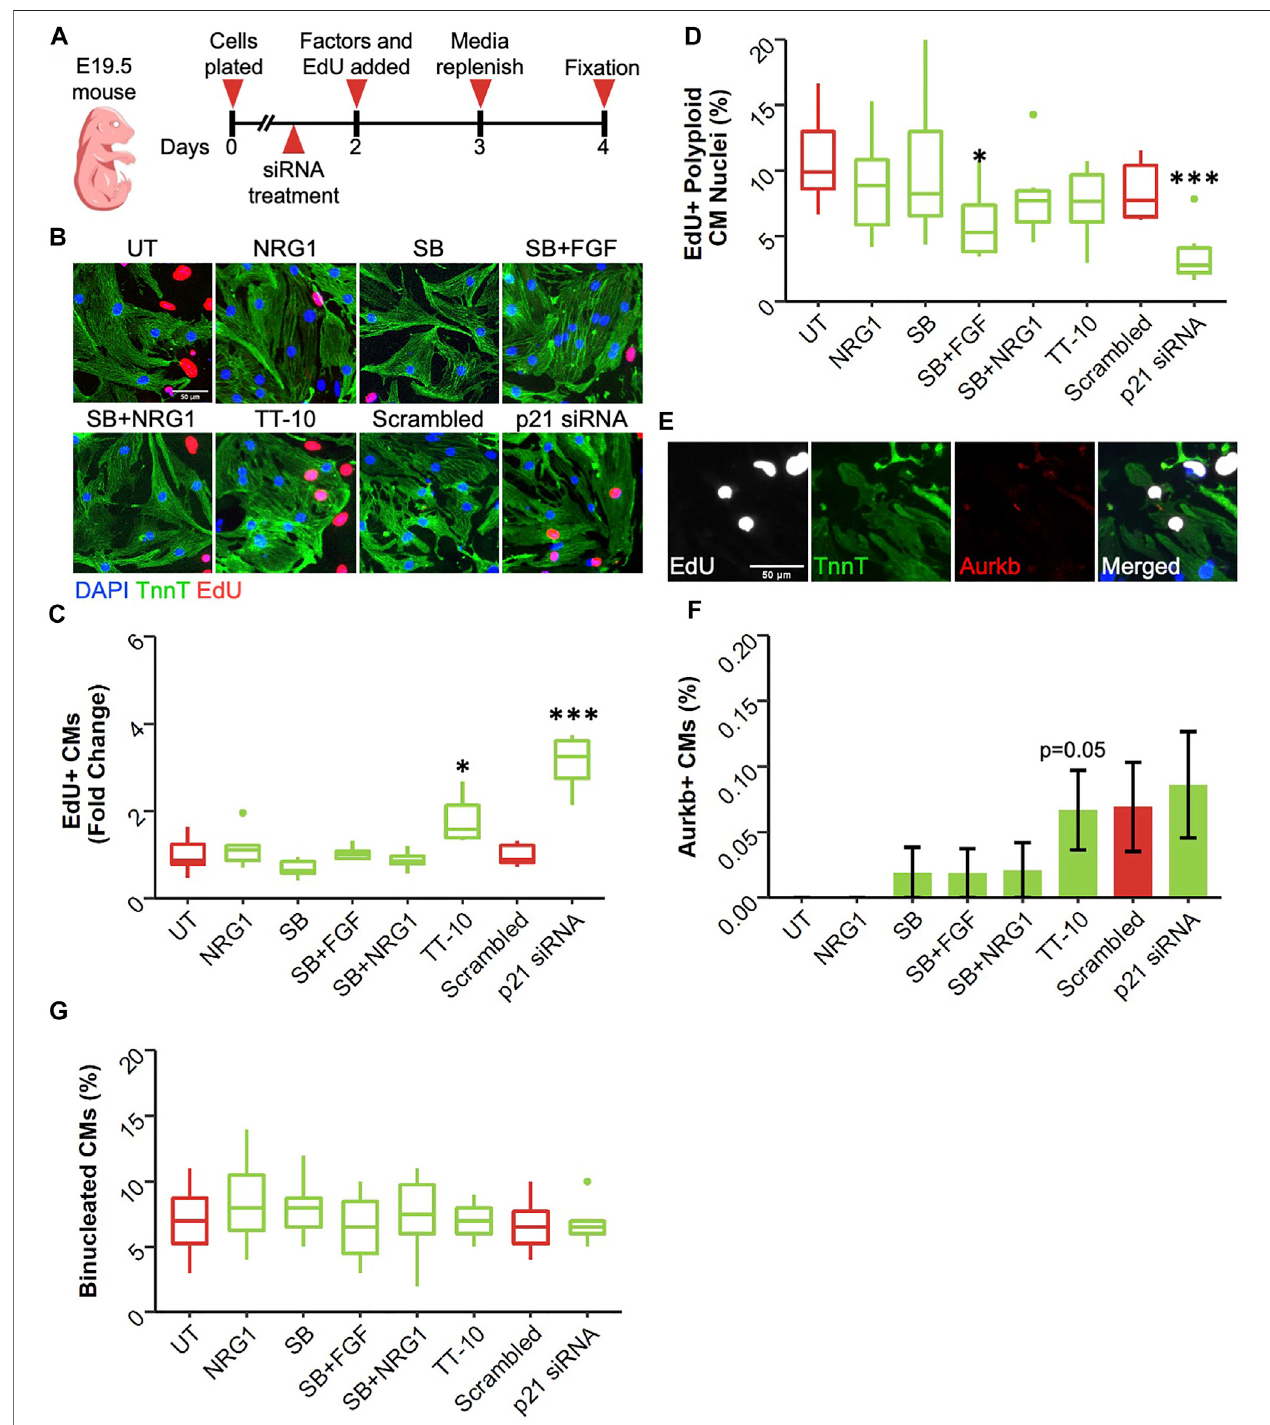
FIGURE4| EffectofproliferativestimulionmouseE19.5cardiomyocytes. (A) Experimentaloutline.E19.5mousecardiomyocyteswereisolatedand platedonDay 0, 36 h later siRNAs and 48 h later proliferative stimuli were added. Edu was added along with proliferative stimuli and was present for the last 48 h of culture. (B) RepresentativeimagesofembryoniccardiomyocytesstainedforTnnT(green),EdU(Red)andDAPI(blue)(scalebar=50 µm) (C) Quanti fi cationofFoldChangeinrelative EdU+CMnuclei(n=6foreachgroup,* p < 0.05,*** p < 0.001) (D) Quanti fi cationofEdU+polyploid(4n+)nucleibasedonDAPIhistograms( n =6,* p < 0.05,*** p < 0.001) (E) RepresentativeimageofAurkb+cardiomyocyteintheprocessofundergoingcytokinesis (F) AbundanceofAurkb+CMsrelativetototalnumber ofCMsafter treatments (n = 6 for each group) (G) Percentage of binucleated CMs at the end of culturing period (n = 6 for each group).